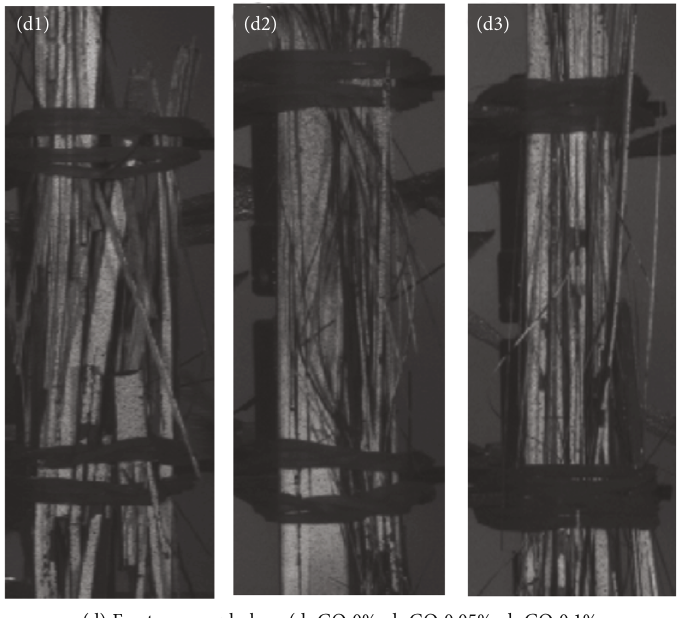
Figure 8: Three-dimensional strain test results of GO-modi fi ed CFRP composites (a1, b1, and c1: Sample morphology during the tensile process; a2, b2, and c2: longitudinal strain; a3, b3, and c3: longitudinal displacement; d1, d2, and d3: Sample morphology at tensile fracture moment).